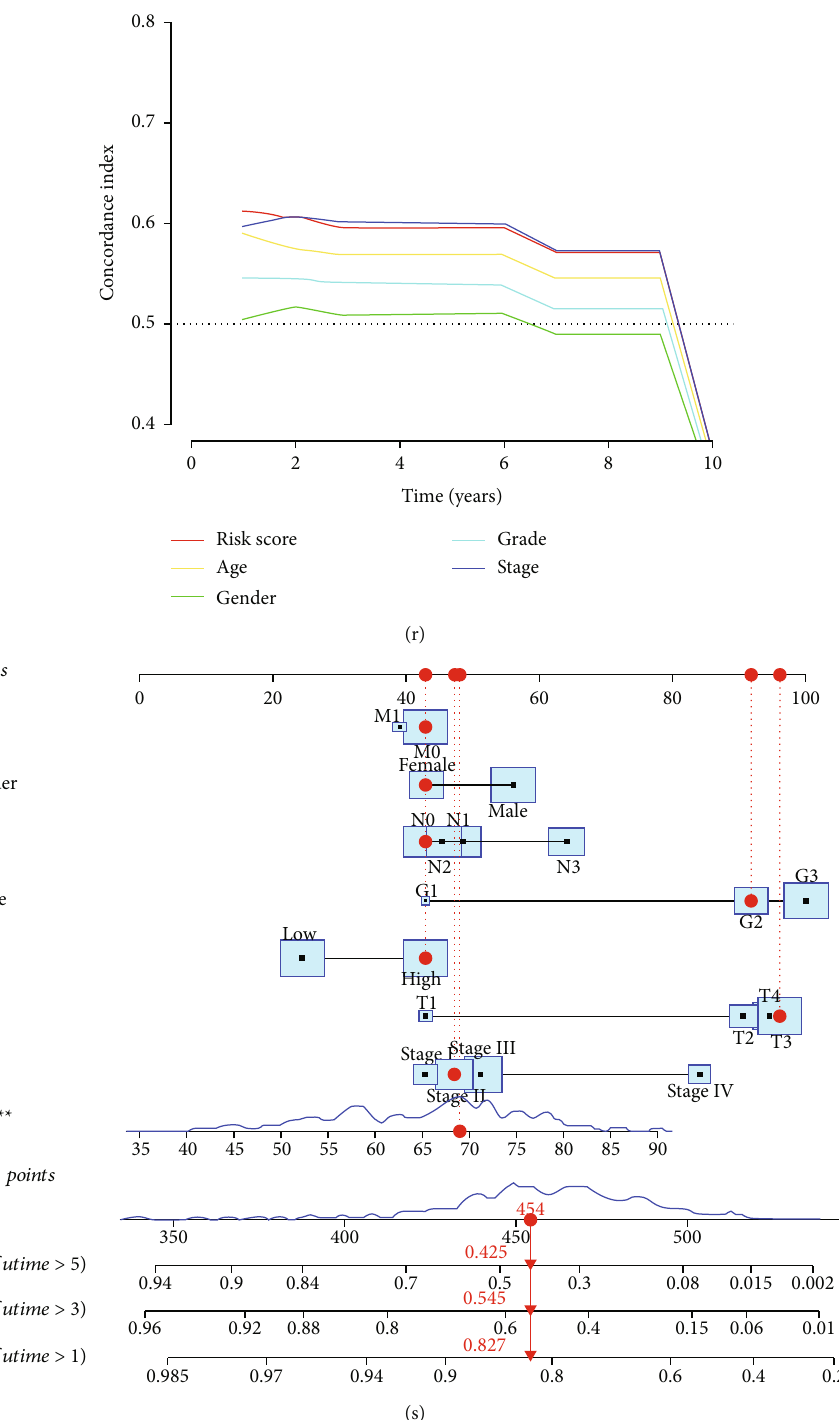
Figure 3: Construction of a GC prognostic model. (a) Survival prognosis curve of total sample group. (b) Survival prognosis curve of training group. (c) Survival prognosis curve of test group. (d) Progression-free survival prognosis curve. (e) Univariate regression independent prognosis analysis. (f) Multivariate regression independent prognosis analysis. (g) Risk score of total sample group. (h) Risk score of training group. (i) Risk score of test group. (j) Survival state diagram of total sample group. (k) Survival state diagram of training group. (l) Survival state diagram of testing group. (m) Heatmap of cuprotosis gene survival analysis in total sample group. (n) Heatmap of cuprotosis gene survival analysis in training group. (o) Heatmap of cuprotosis gene survival analysis in test group. (p) ROC curve of fi ve-year survival of GC. (q) Risk of GC factor ROC curve. (r) GC C-index curve. (s) GC cuprotosis prognostic model